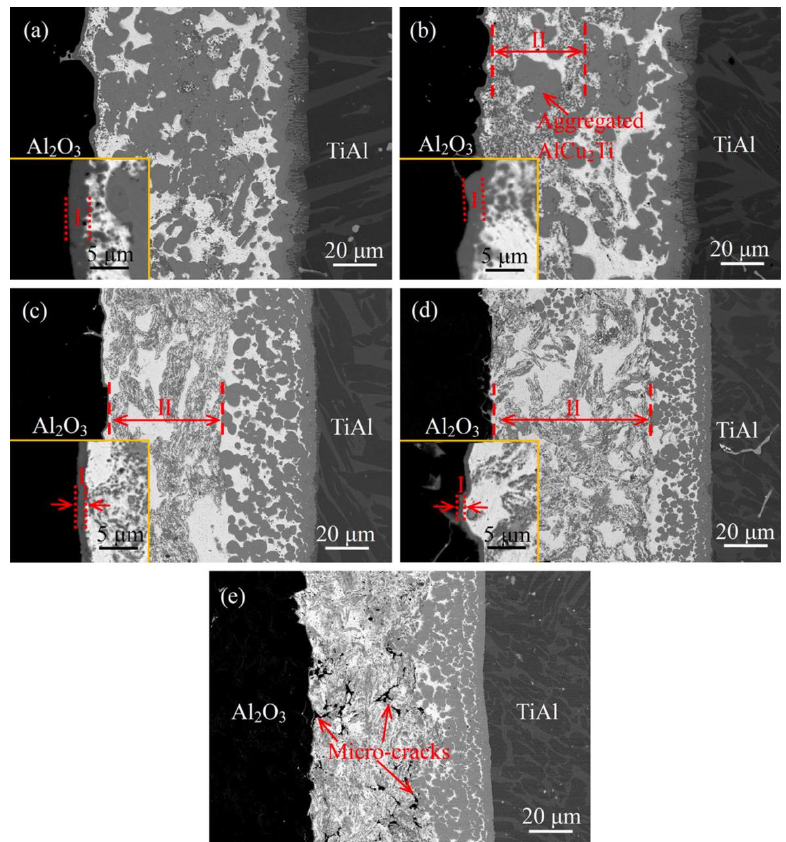
Figure 3. Microstructure of the TiAl/Al 2 O 3 joint brazed at 880 °C for 10 min with different B contents: ( a ) 0, ( b ) 0.2, ( c ) 0.5, ( d )1.0 and ( e ) 1.5 wt%, reproduced from Reference [24] with permission of Elsevier,